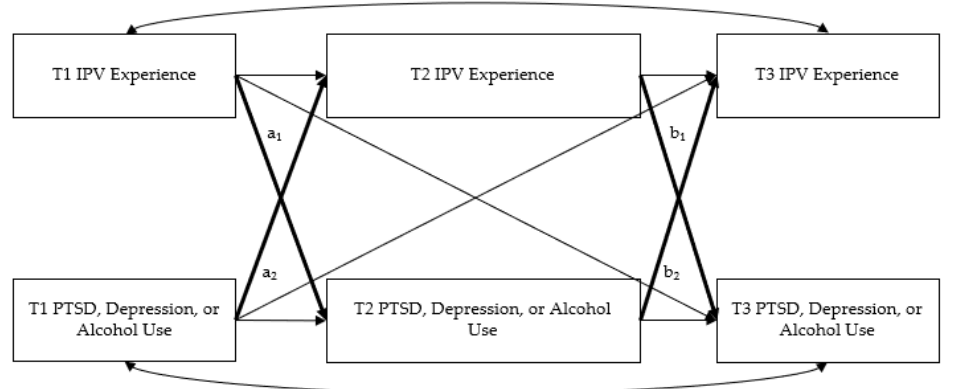
Figure 1. Predicted model examining the bidirectional effects of IPV on mental health outcomes.